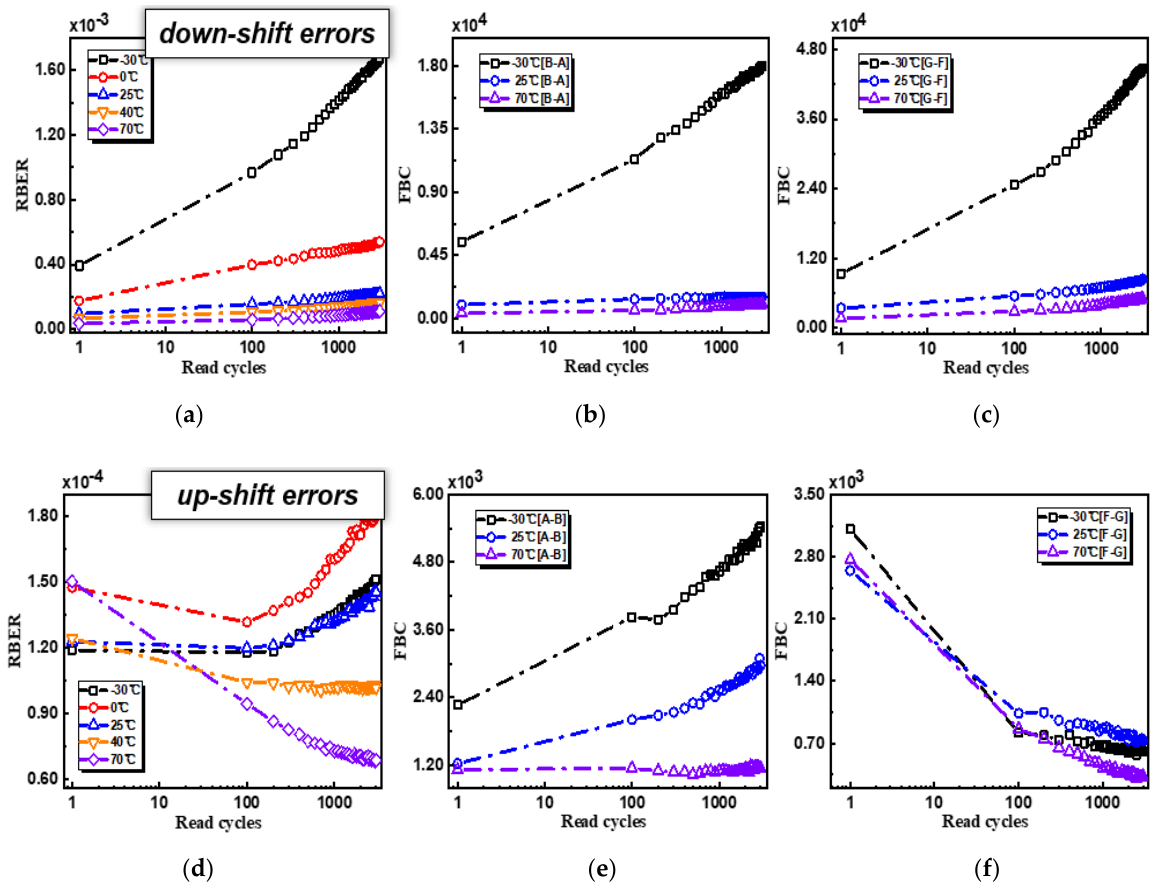
Figure 6. Read disturb-related RBER changes were divided into ( a ) down-shift errors and ( d ) up-shift errors from − 30 to 70 °C; ( b , c ) compares B-to-A errors and G-to-F down-shift errors, respectively, while ( e , f ) compares A-to-B errors and F-to-G up-shift errors, respectively, at − 30, 25, and 70 °C.